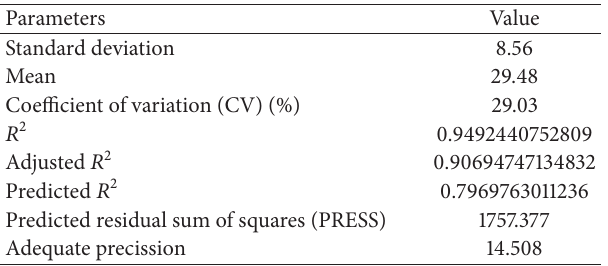
Table 7: Analysis of variance for the regression model and respec- tive model terms.